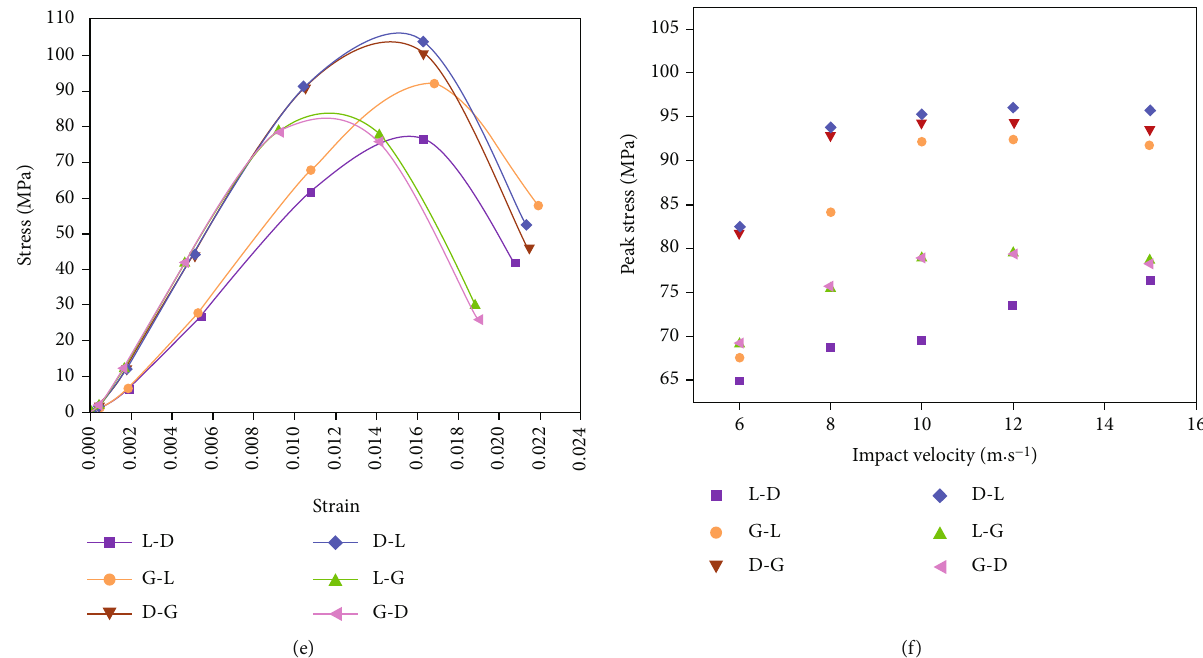
Figure 4: Comparison of stress and strain of layered rock mass under di ff erent impact velocities: (a) 6m/s; (b) 8 m/s; (c) 10m/s; (d) 12 m/s; (e) 15m/s; (f) peak stress comparison.